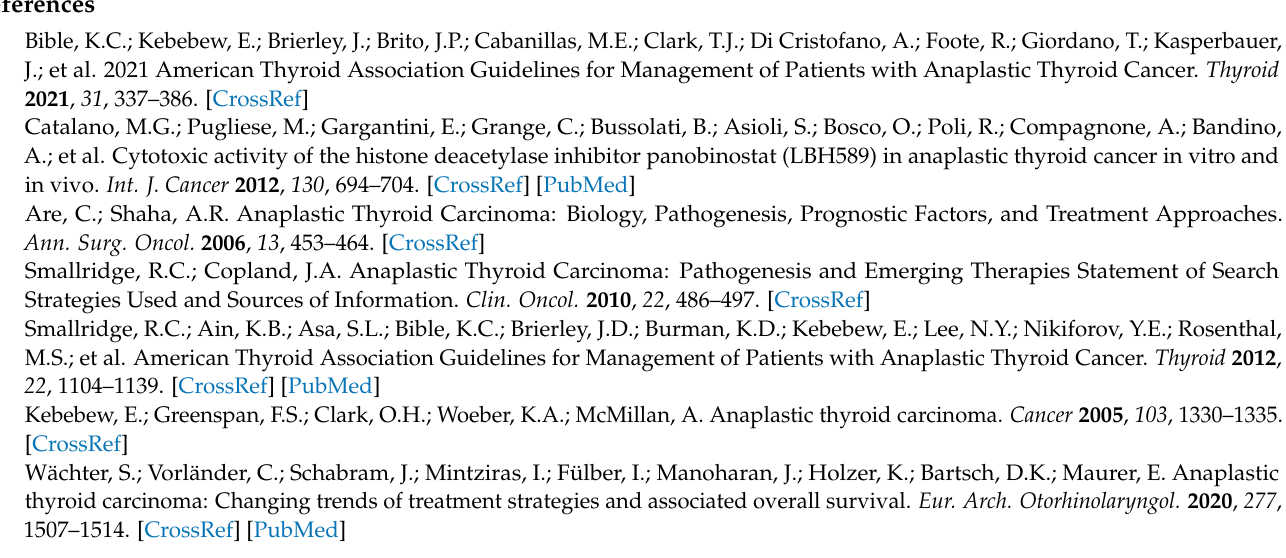
Figure S6: Patient 6: 18FDG-PET/CT (A,B), 68Ga-PSMA-PET/CT